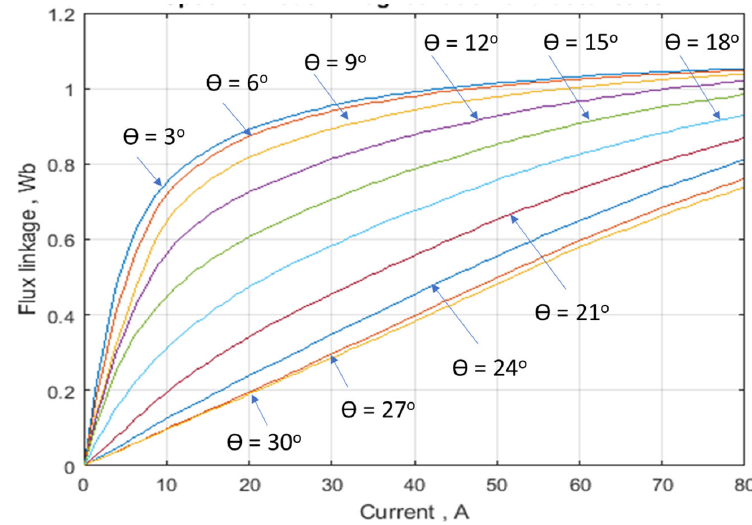
Figure 1. Magnetization characteristics of 75 KW, 8/6, 4 phase SRM at different rotor positions. In Equation (3), T e ( i , θ ) is the electromagnetic torque and is extracted from the machine’s coenergy: